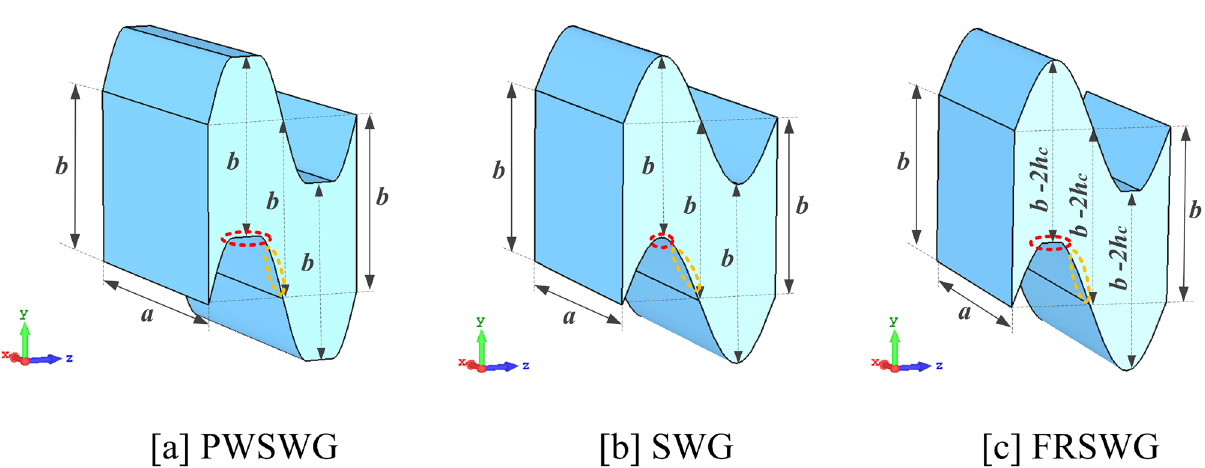
Figure 2. Comparisons of the 3D structure model of the PWSWG, the SWG and the